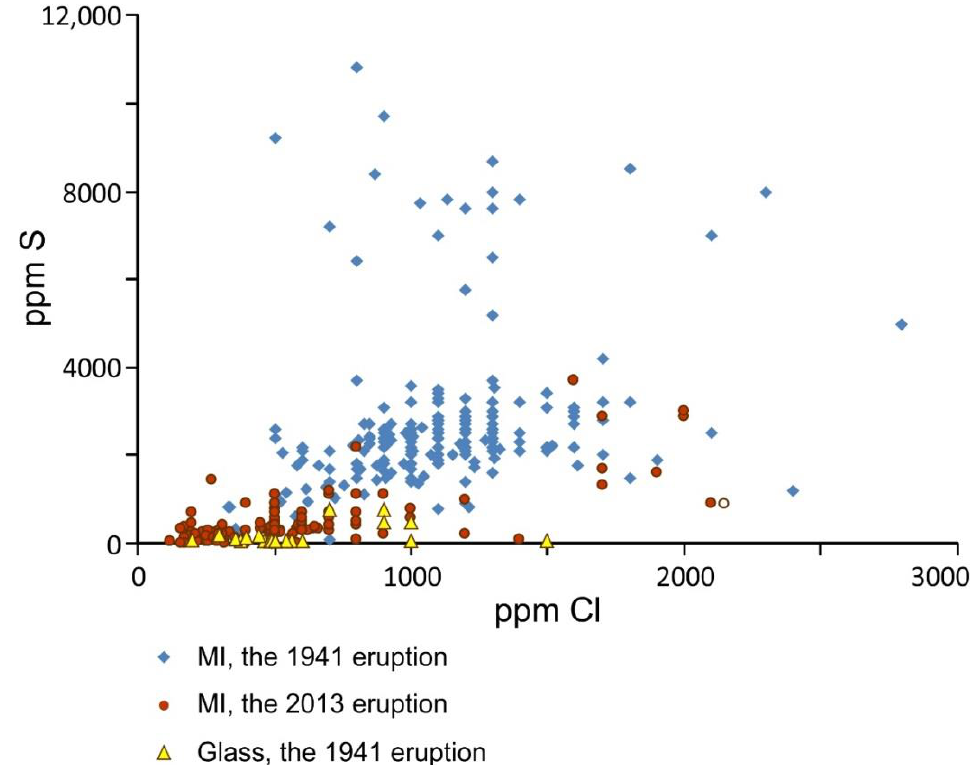
Figure 2. Variation diagram for Cl vs. S for naturally quenched melt inclusions from the 1941 and 2012 – 13 Tolbachik eruptions and groundmass glass for comparison. About 90% of inclusions fall on the degassing trend. The minimum sulfur concentration in quenched glasses is 50 – 60 ppm with chlorine equal to 300 – 500 ppm. The maximum sulfur concentrations in common non-degassed MI from the 1941 Tolbachik eruption reach 3200 – 3600 ppm S with chlorine of up to 1500 ppm. Melt inclusions in olivine from the 2013 Tolbachik eruption are shown for comparison. The 2013 inclusions represent high-alumina basalts (Supplementary Table S2) and form a similar degassing trend, but with systematically lower sulfur and chlorine concentrations. Modified from [28]; new data added.